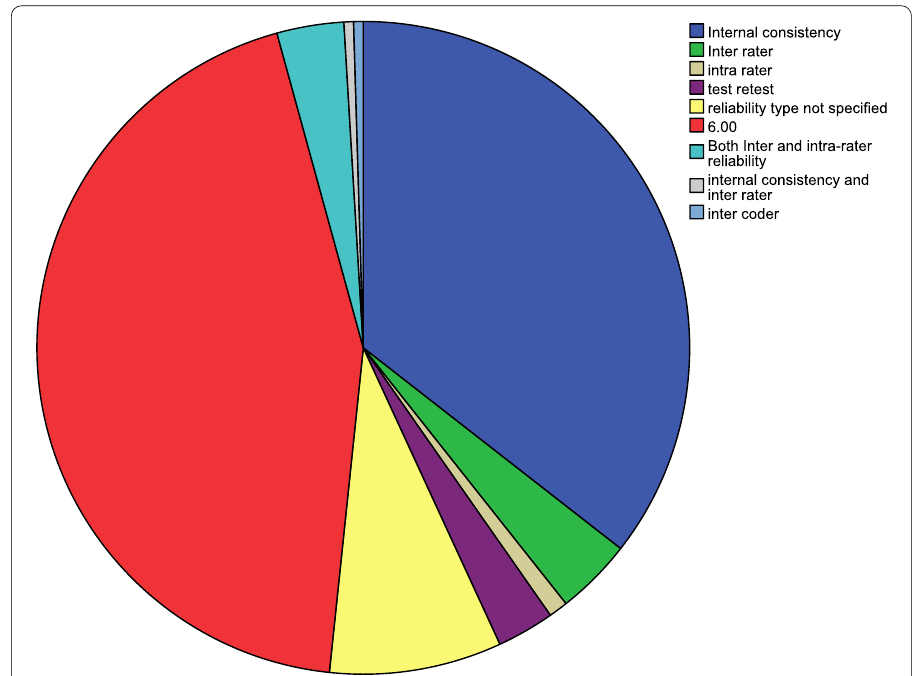
Fig. 2 Frequency of reporting each reliability